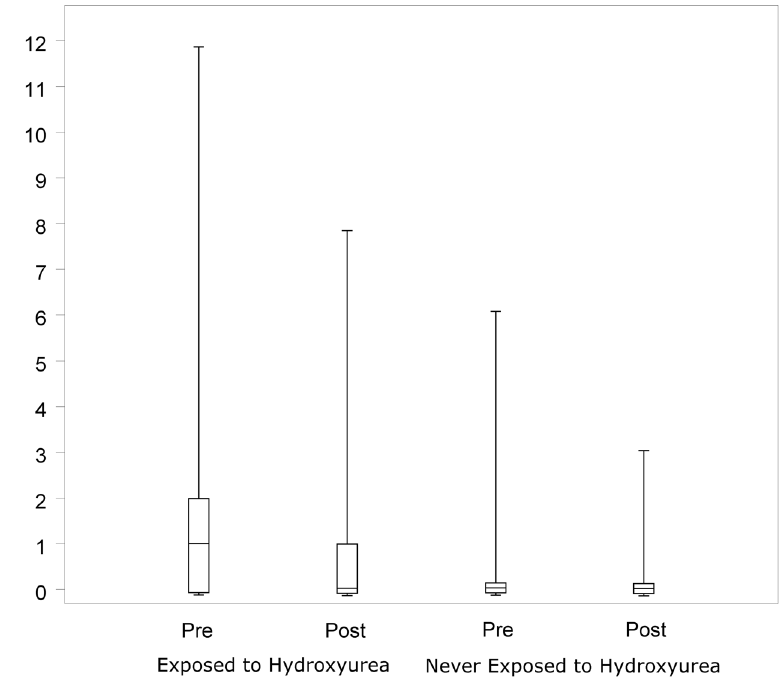
Figure 1. Boxplots show the distribution of hospitalizations by hydroxyurea exposure status for the time period pre- and post- initiation of HU or pre- and post- the study mid-point. Subjects exposed to HU (n=205) experienced a median decrease of 1 hospitalization per year after initiation of HU (p , 0.001). Subjects never exposed to HU (n=197_ experienced no discernible change in yearly hospitalizations (p=0.30) for the years immediately preceding and following the study mid-point. Boxplots show the minimum, 1 st quartile, median, 3 rd quartile, and maximum for each group after a jittering technique was applied to aid the visual presentation of overlapping data points.